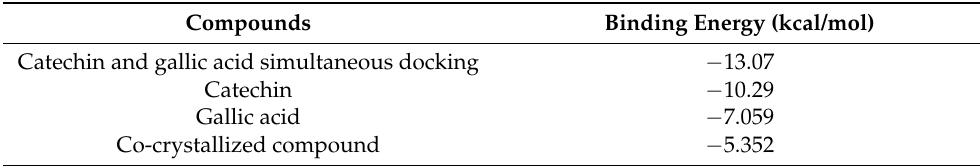
Table 3. Docking scores of catechin, gallic acid, and their combination against the transcriptional activator receptor ( Las R) using AutoDock Vina